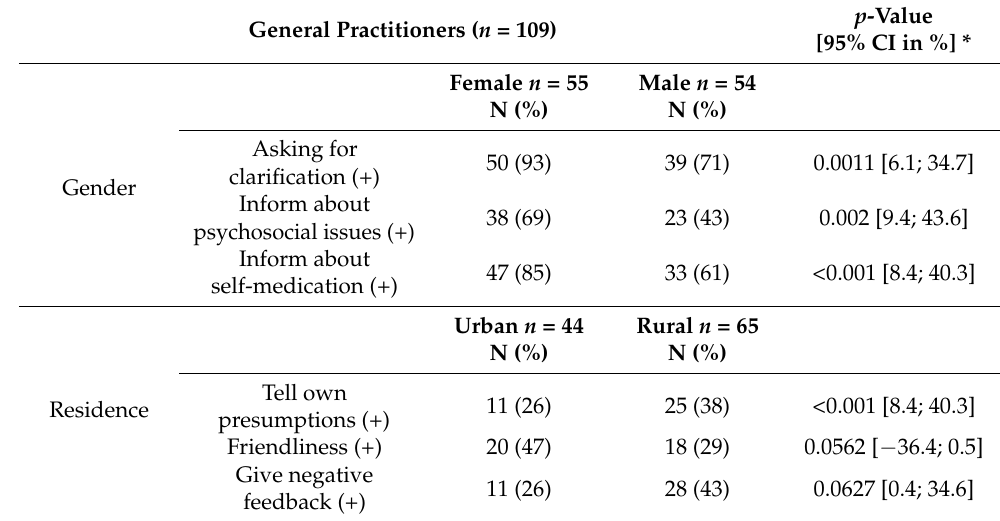
Table 3. Gender-specific and urban-rural differences among general practitioners.